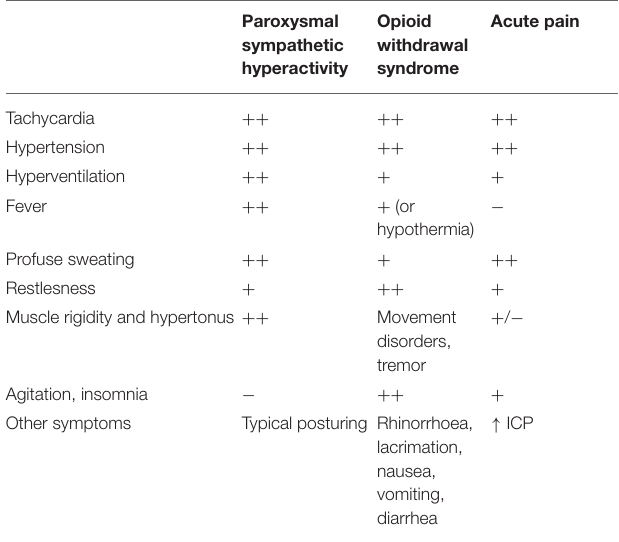
TABLE 1 | The most common symptoms of paroxysmal sympathetic hyperactivity, withdrawal syndrome, and acute pain in neurosurgical